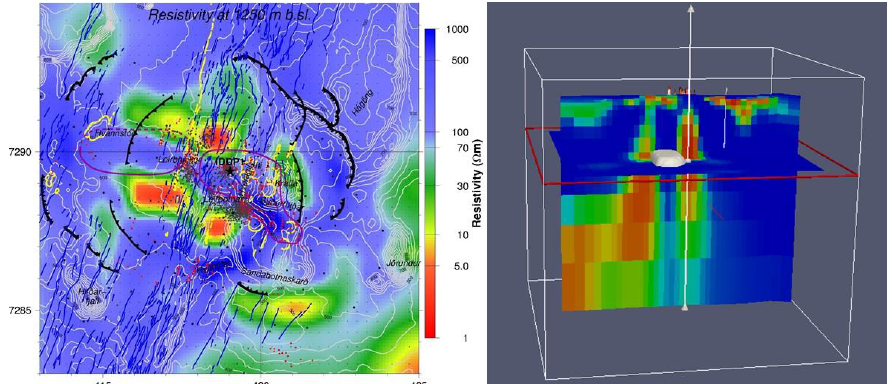
Figure 10. A resistivity model for Krafla from 3D inversion of MT data. Left: resistivity map at 1250 m bl. sl. The two calderas are shown as black hatched lines, purple lines mark the S-wave shadows, grey dots are earthquake epicentres and blue lines are faults and fissures. The location of the well IDDP-1 is shown as a black star. Right: 3D view from the west. The white surface shows the upper boundary of the western S-wave shadow at 3 km depth (reproduced from [31]). Coordinates are UTM WGS84 zone 28 in km.